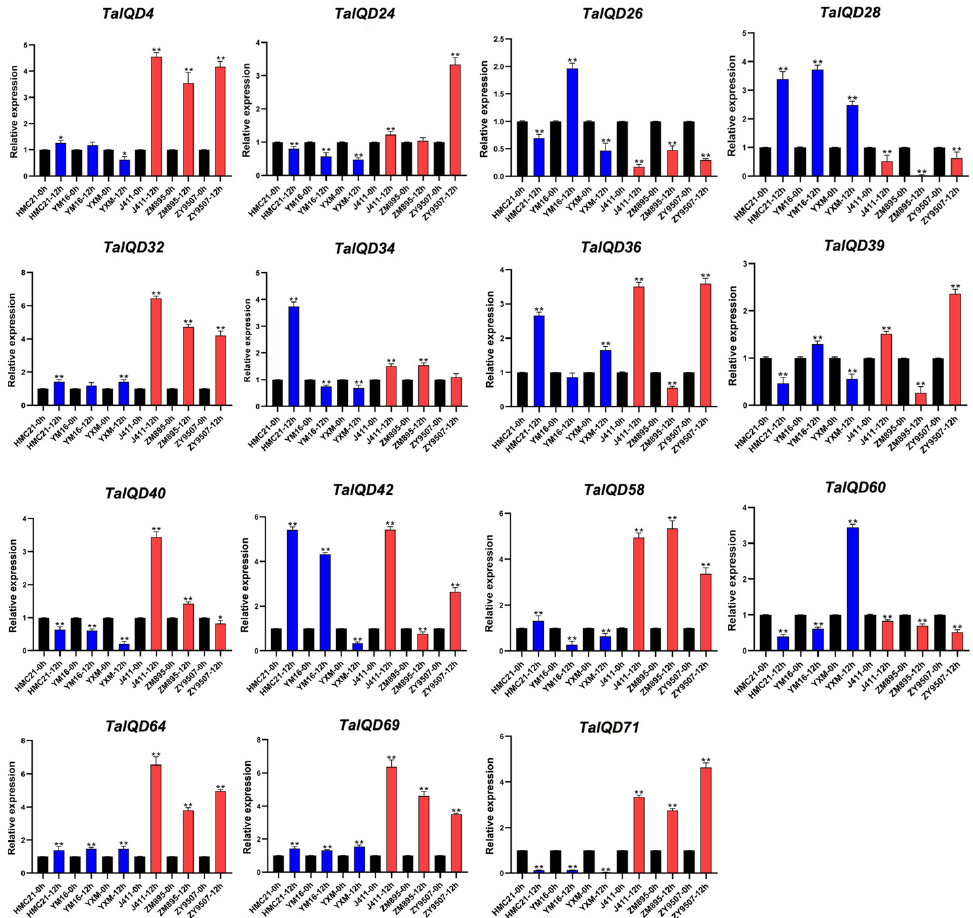
Figure 8. Expression patterns of 15 TaIQDs during seed imbibition in six wheat varieties with contrasting seed dormancy phenotypes. Red indicates weak-dormancy varieties, and blue indicates strong-dormancy variety. Y axes represent the scales of the relative expression levels. Bars represent the standard deviations (SDs) of three biological replicates. The significance criteria used were * p < 0.05 and ** p <